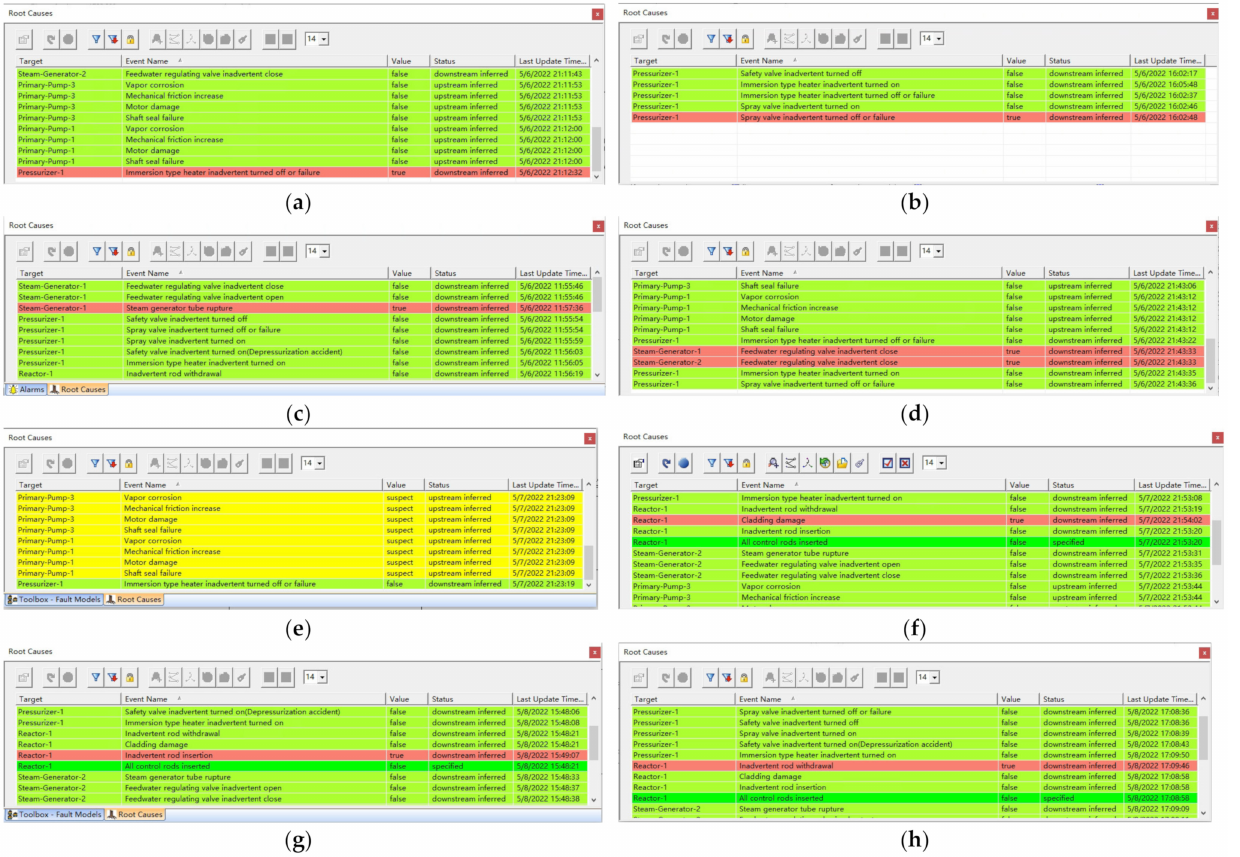
Figure 27. Diagnostic results: ( a ) immersion-type heater inadvertently turned off or failure; ( b ) spray valve inadvertently turned off or failure; ( c ) steam generator tube rupture; ( d ) feedwater regulating valve inadvertently closed; ( e ) low flow reactor coolant loop; ( f ) cladding damage; ( g ) inadvertent rod insertion; ( h ) inadvertent rod